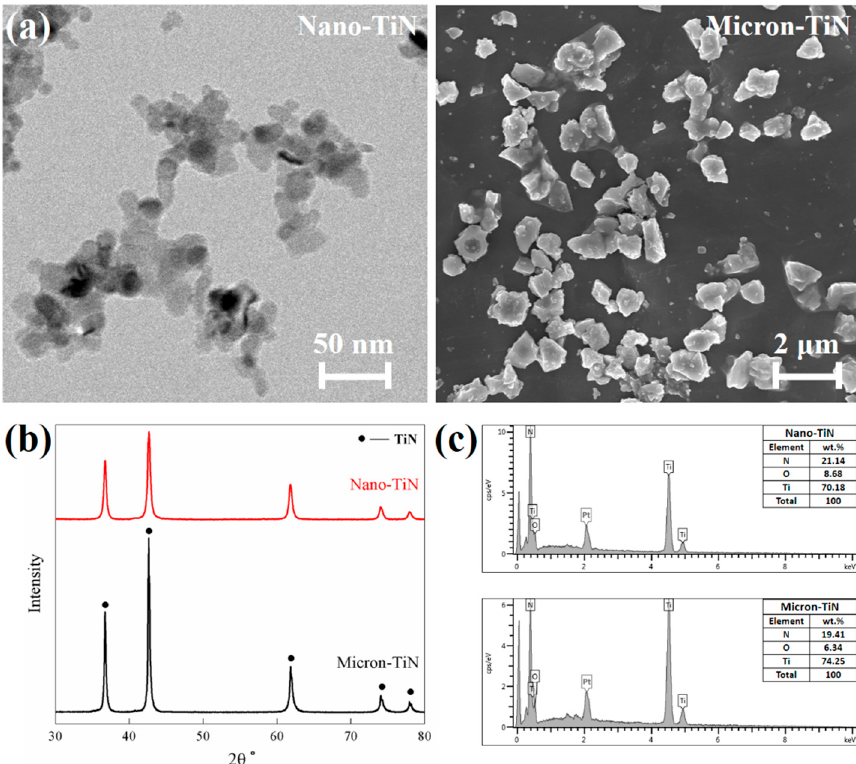
Figure 1. Basic characteristics of the as-received TiN particles: ( a ) electronic micrographs [11]; ( b )